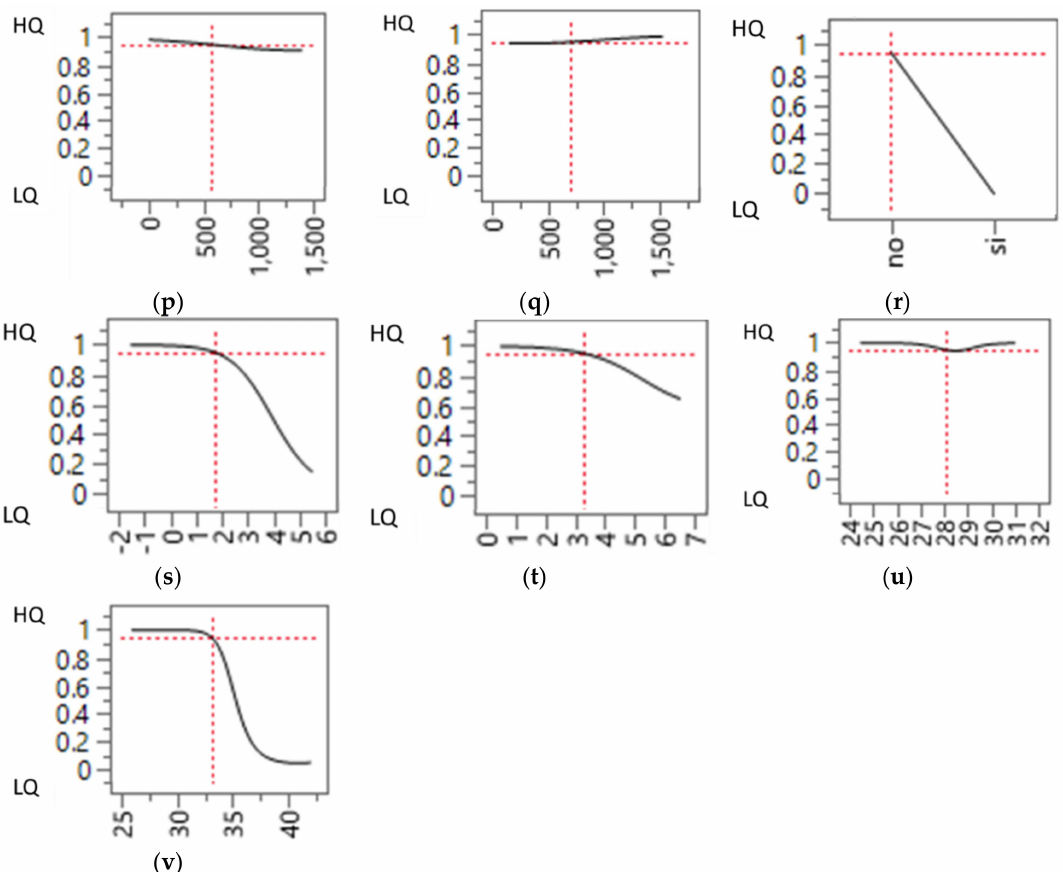
Figure 2. Profile graphs of the neural network model for all the pre-slaughter variables presented in Table 2. For each graph, the name of the variable plotted on the x -axis is indicated below the figure. (HQ = High quality cluster; LQ = Low quality cluster). Variable names highlighted in bold character indicate statistically significant di ff erences ( p < 0.05) between clusters, as presented in Table 2. ( a ) Loading duration, min. ( b ) Pigs loaded per hour, n. ( c ) Irregular behaviors at loading, %. ( d ) Waiting time at the farm, min. ( e ) Journey duration, min . ( f ) Ambient temperature, ◦ C . ( g ) Distance traveled, km . ( h ) Average vehicle speed, km / h. ( i ) Waiting time at slaughterhouse, min. ( j ) Total journey duration, min. ( k ) Total waiting time on the truck, min. ( l ) Unloading duration, min. ( m ) Pigs unloaded per hour, n. ( n ) Irregular behaviors at unloading, % . ( o ) Total irregular behaviors. ( p ) Lairage duration, min. ( q ) Transport + lairage duration, min. ( r ) Stable (unmixed) groups, odds ratio. ( s ) On-departure (at farm) score, pts. ( t ) Transport score, pts. ( t ) Slaughter score, pts. ( u ) TSWI,